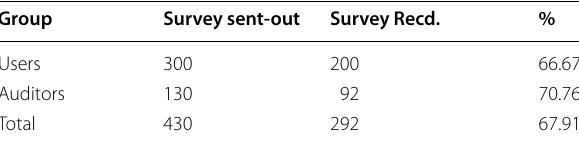
Table 1 Respondents response. Source: Survey Data